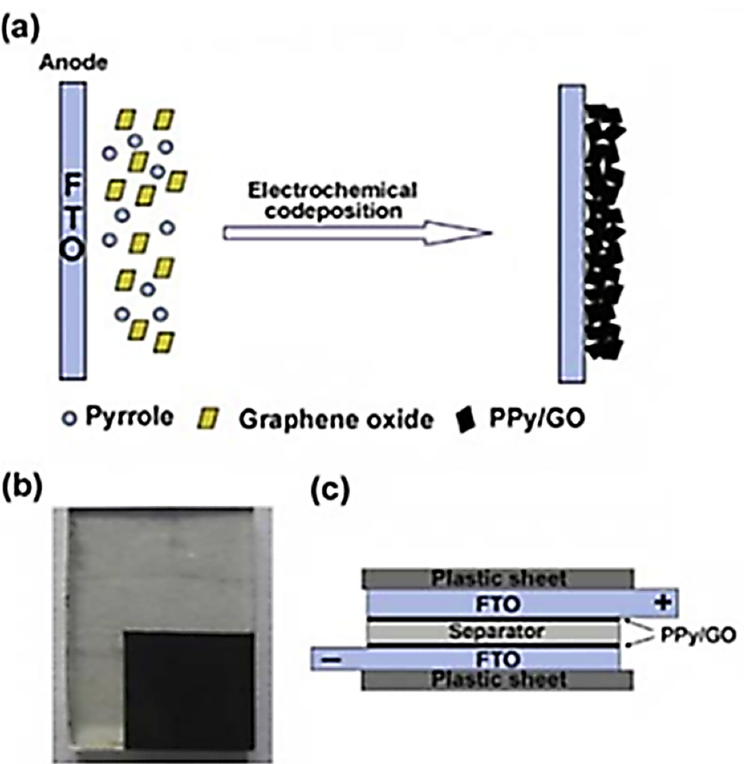
Figure 9. ( a ) Schematic for electrochemical co-deposition of PPy/GO nanocomposites; ( b ) real photo of PPy/GO-deposited FTO conducting glass; ( c ) construction of supercapacitor cell [105]. PPy/GO = polypyrrole/graphene oxide; FTO = Fluorine-doped tin oxide.